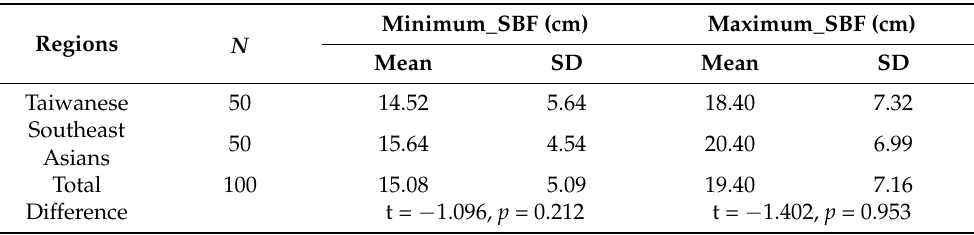
Table 1. Mean (standard deviation, SD) span between feet (SBF) values of two participant groups and the independent t -test results.